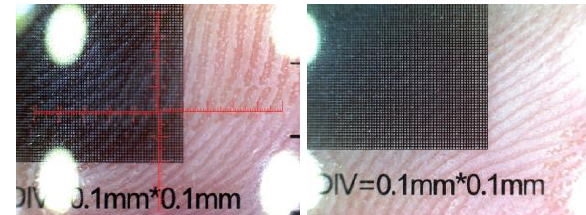
Figure 4. Direct measurement with the help of a microscope micrometer calibration ruler on the